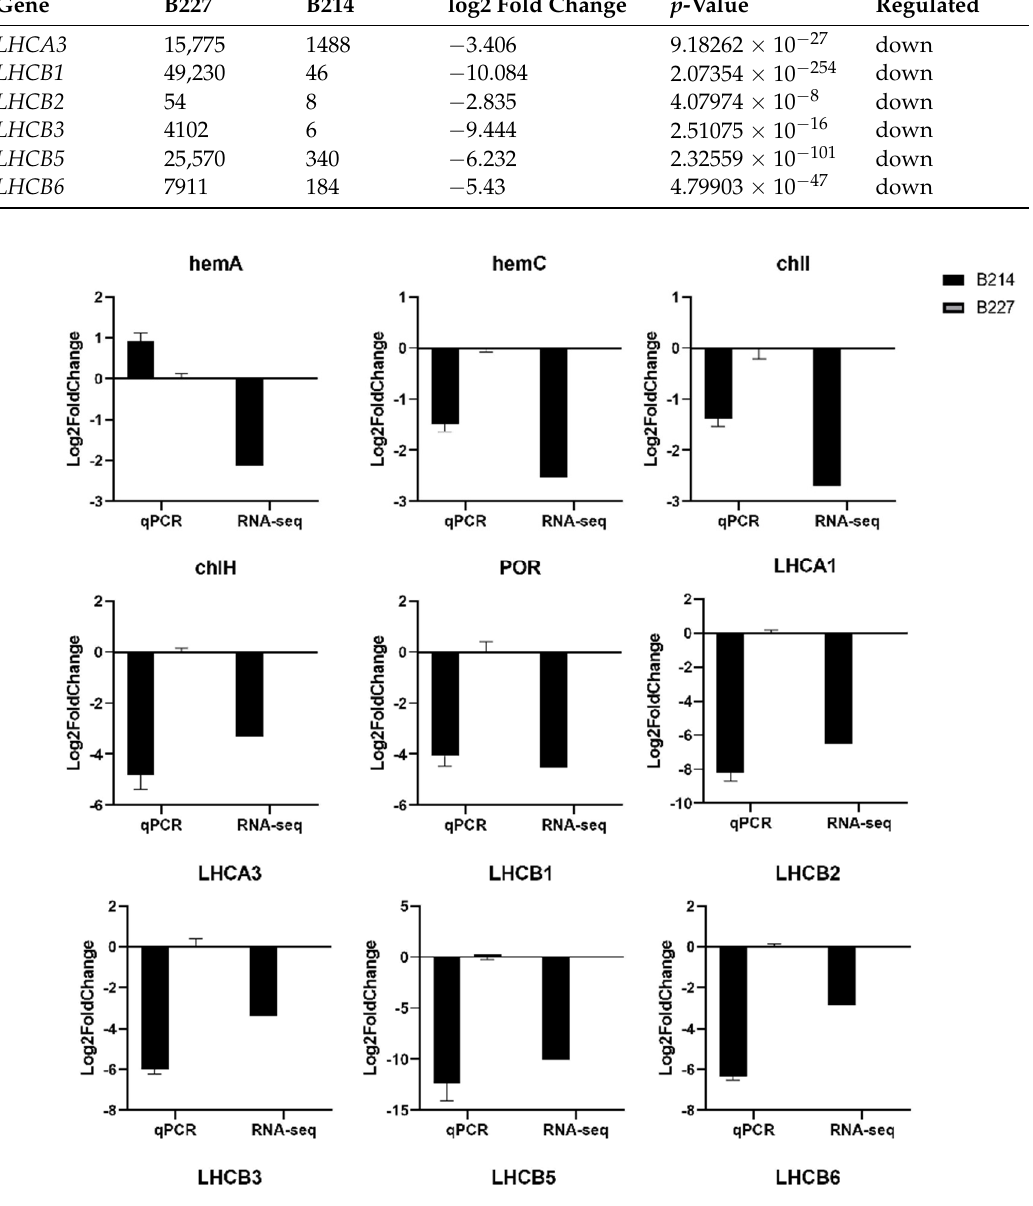
Figure 6. qRT-PCR verification of transcriptomic analysis results.